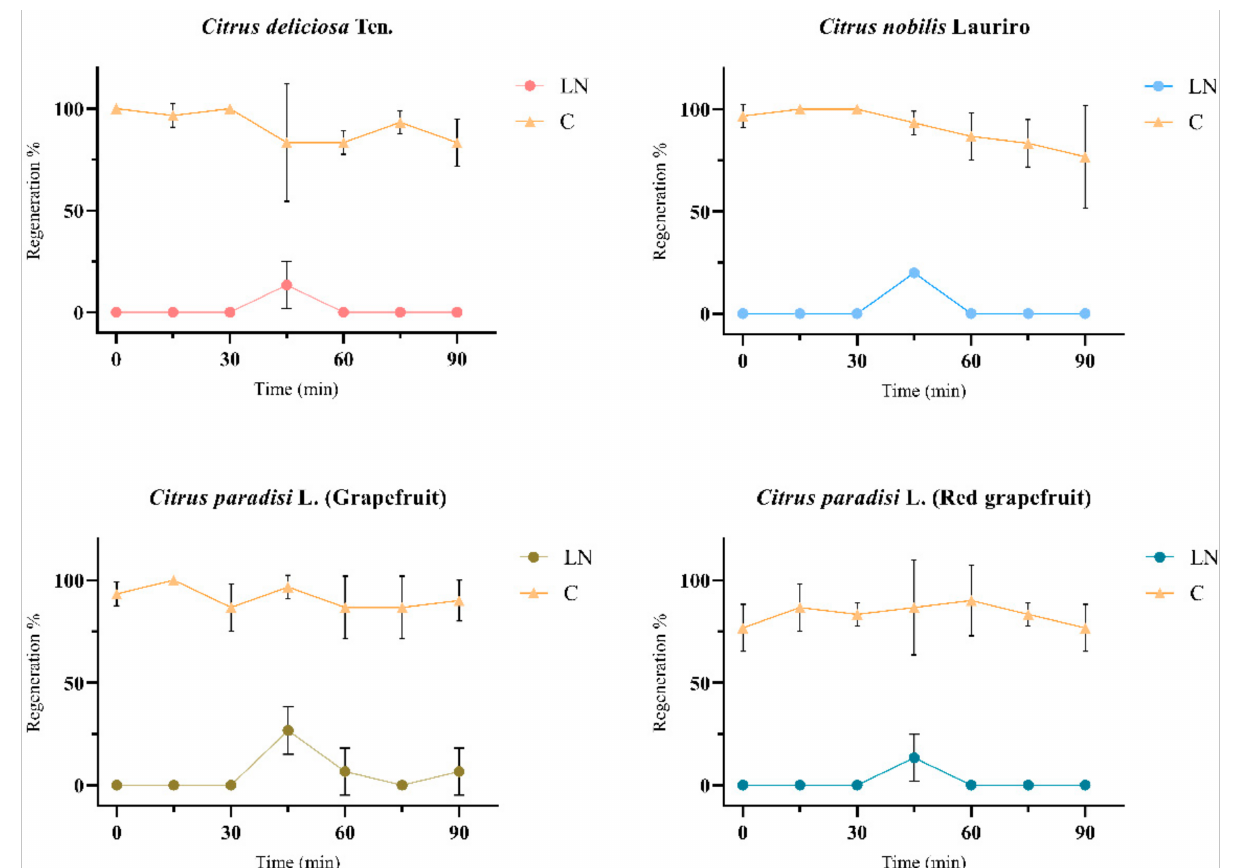
Figure 5. The shoot-tips regenerations of liquid nitrogen (LN) and control (C) groups of four different Citrus spp. cultivars after cryogenic applications on solid WPM medium supplemented with 1 mg.L − 1 BAP, 10 mg.L − 1 activated charcoal, and 1 mg.L − 1 FeEDDHA. The graphs were formed according to the shoot tip regeneration data, which obtained the best regeneration in the optimized cryogenic applications and then treated with PVS2 at different times. In addition, shoot tips untreated with PVS2 (0 min) were also given as the control group of PVS2 treated with different time in graph. The graphs represent the mean ± SD ( p <